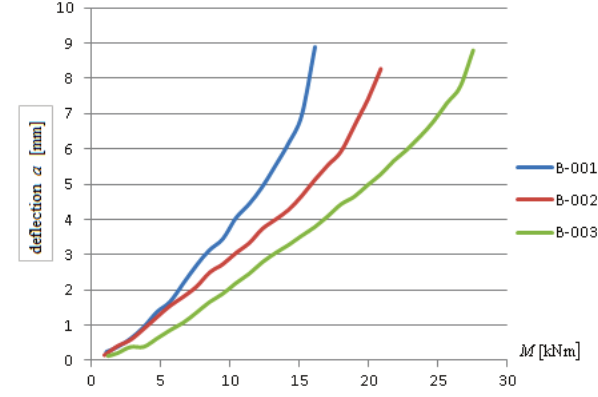
Fig. 7. Graph of deflections of RC beams versus value of the bending moment